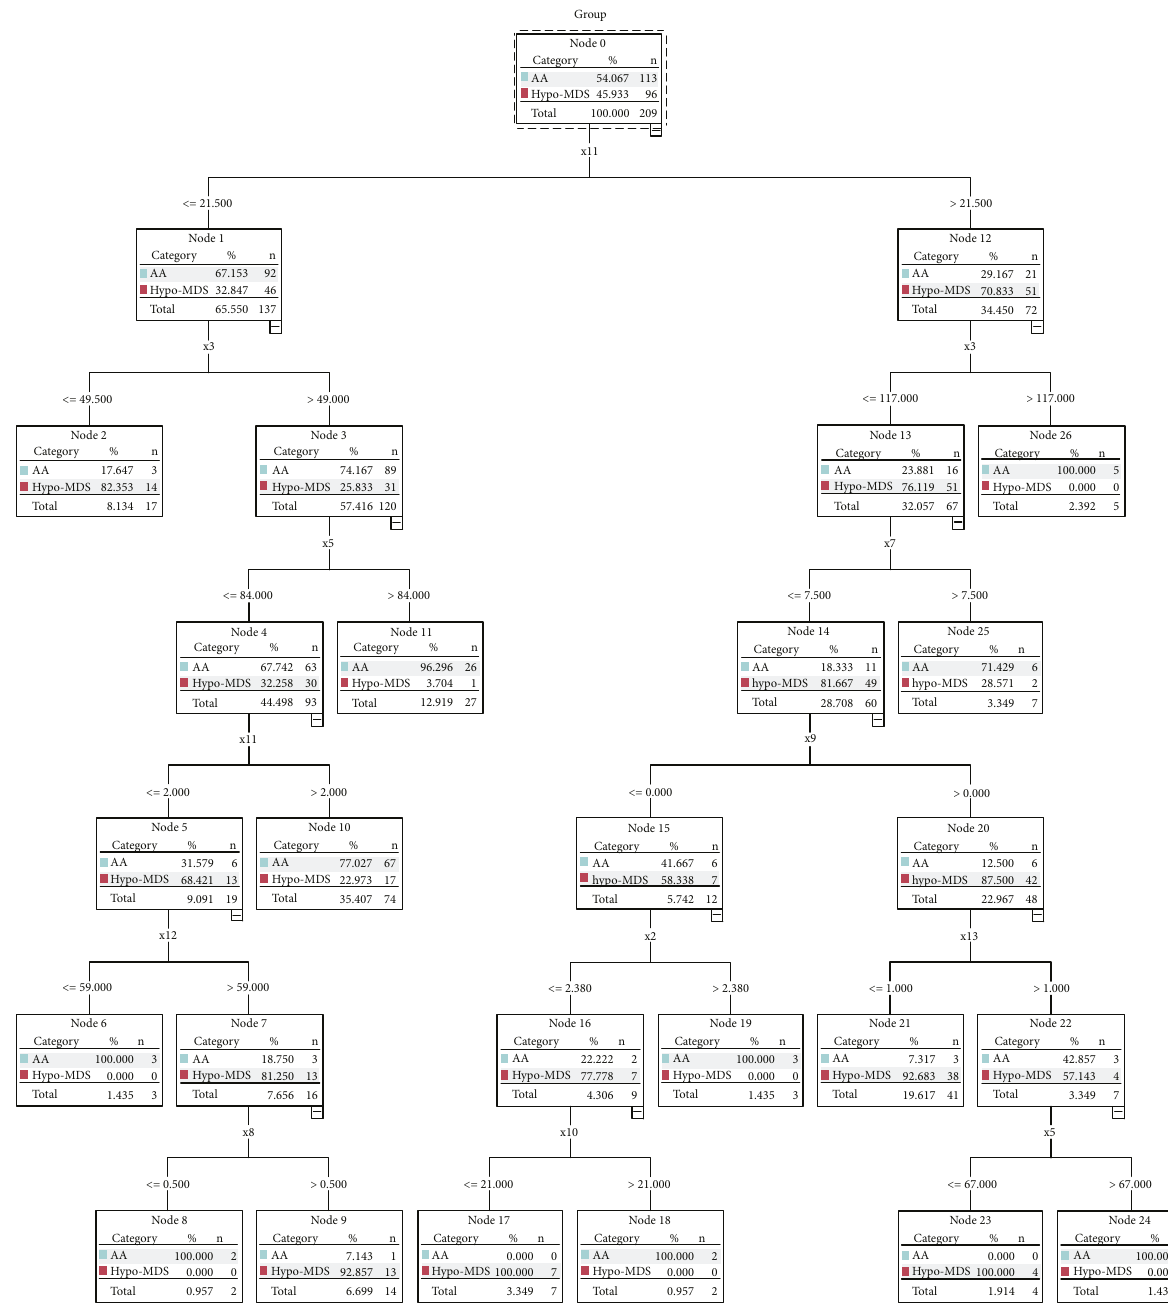
Figure 4: Decision tree model of hypo-MDS and